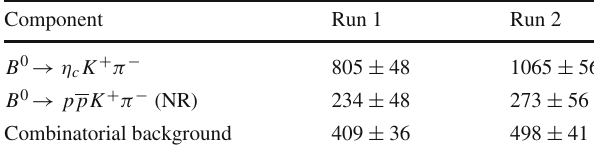
Table 2 Yields of the components in the 2D mass fit to the joint [ m ( ppK + π − ) , m ( pp ) ] distribution for the Run 1 and 2 subsamples